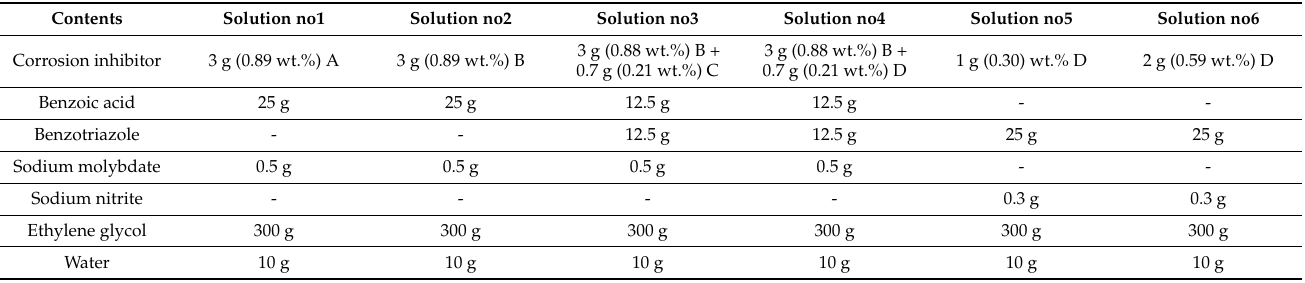
Table 1. The compositions of antifreeze solutions used in this study (Inhibitors A, B, C, and D are defined in Table 2).